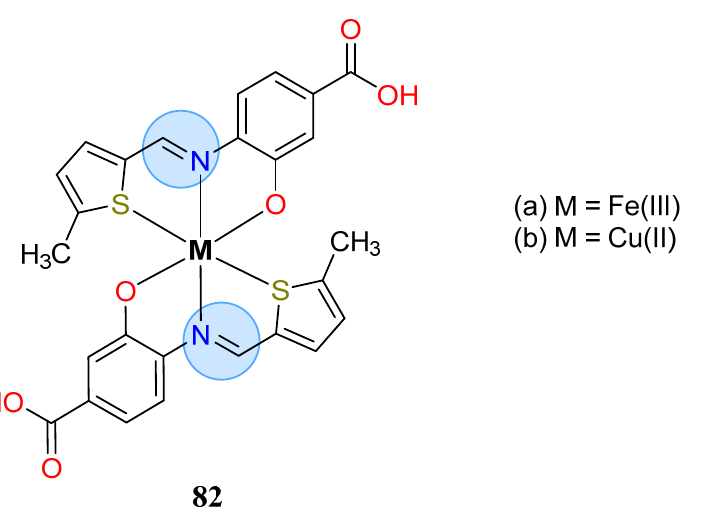
Figure 41. Iron(III) and copper (II) complexes of Schiff base ligand named (Z) ‐ 3 ‐ hydroxy ‐ 4 ‐ ((5 ‐ me ‐